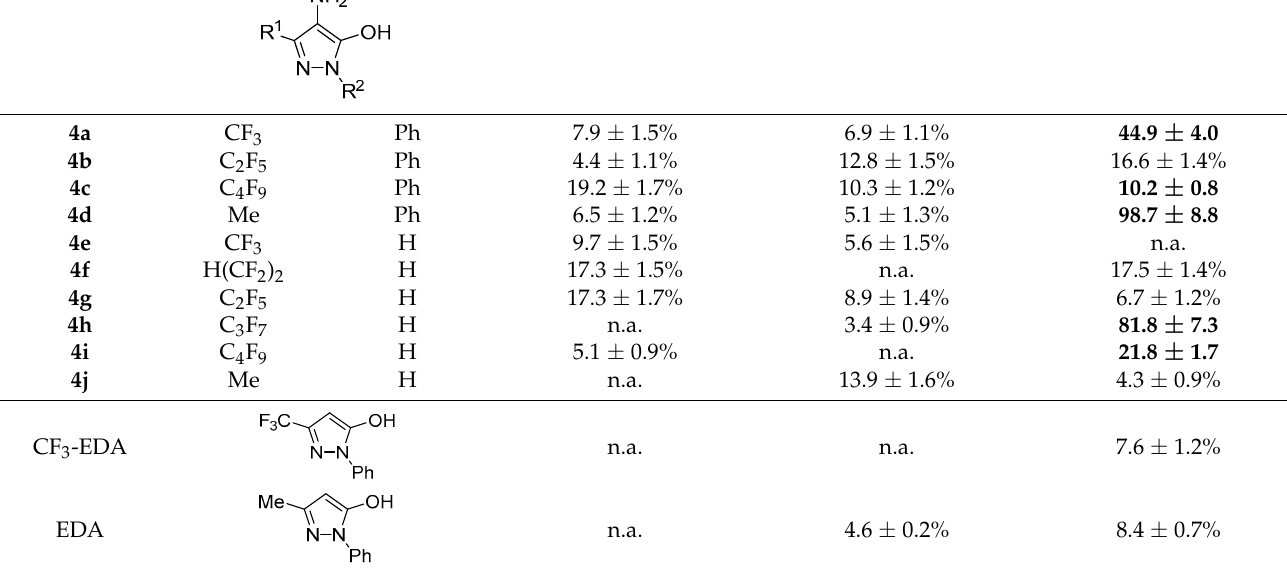
1 Percentages correspond to percent inhibition ± SEM at 20 μ M, n = 3. 2 Values without units of measurement (numbers printed in bold) correspond to IC 50 ± SEM in μ M, n = 3. n.a.—not active.